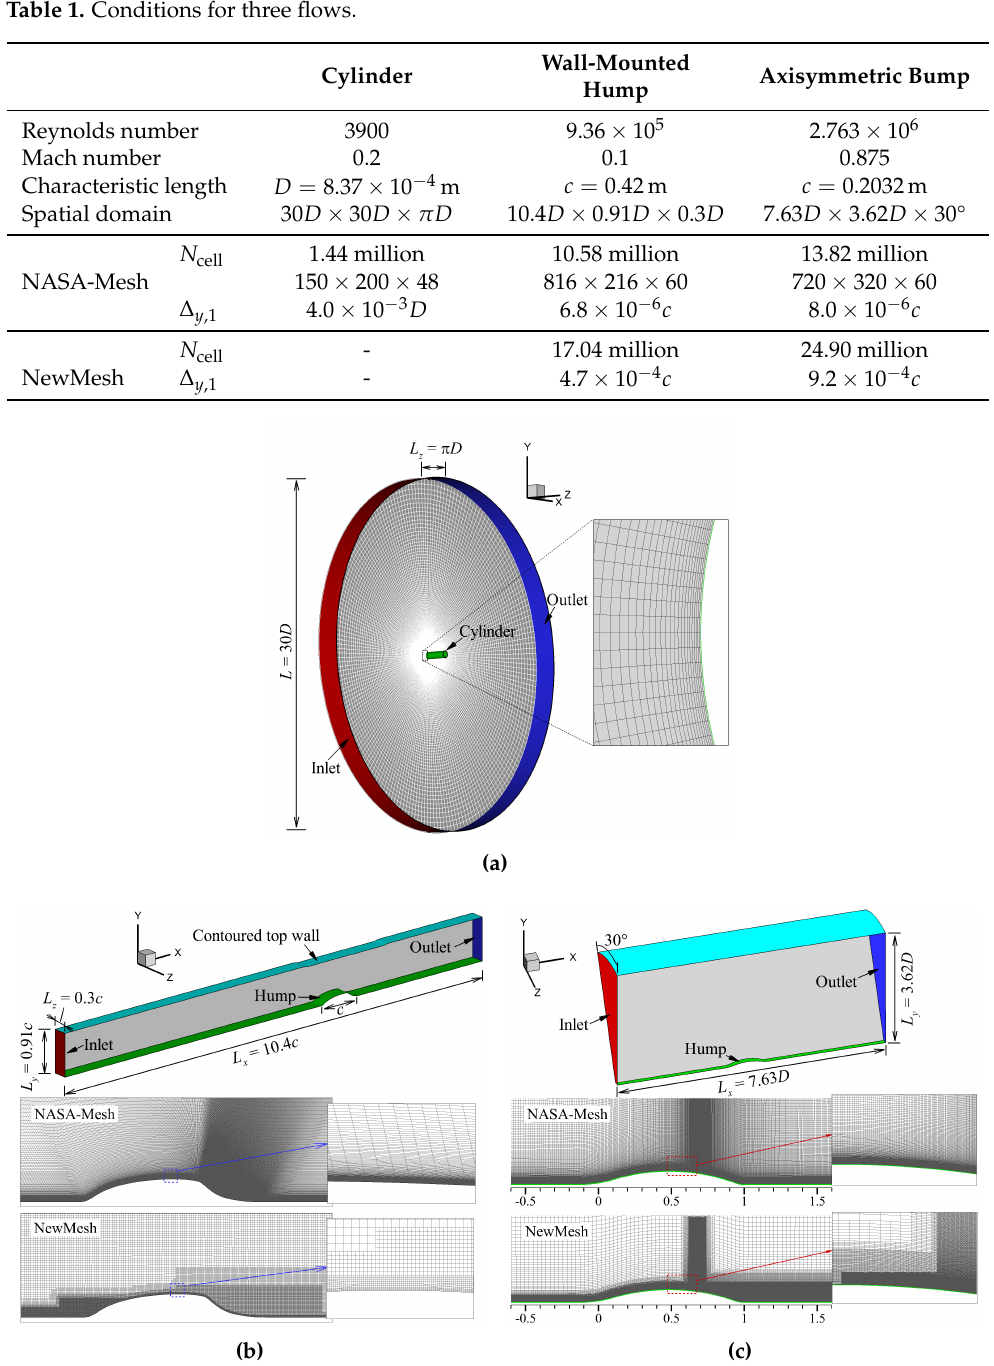
Figure 3. Geometric structures and computational domains for ( a ) cylinder, ( b ) wall-mounted hump and ( c ) axisymmetric bump